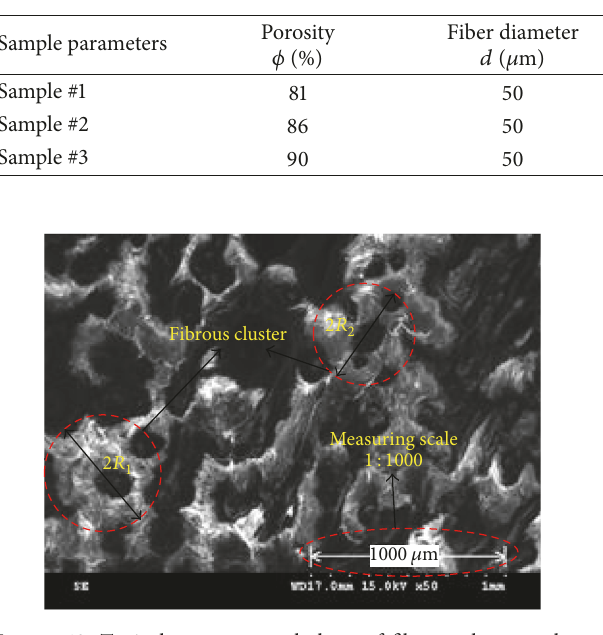
Figure 10: Typical porous morphology of fibrous clusters where 𝑅 denotes the fibrous cluster radius and the measuring scale of calculation is